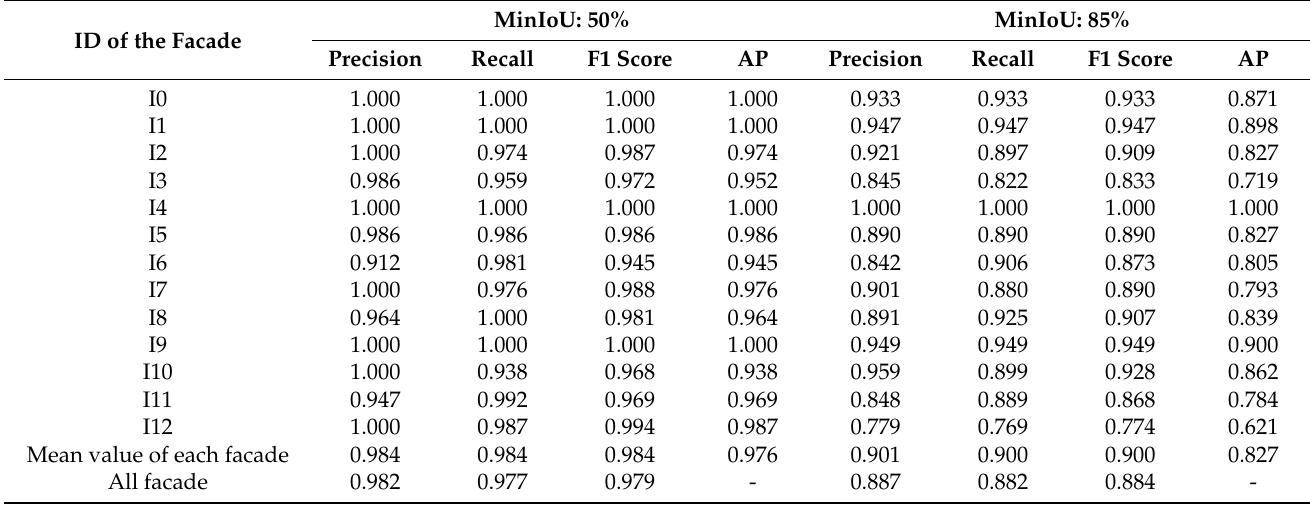
Table 2. Accuracy of window extraction for the IQmulus & TerraMobilita Contest dataset.